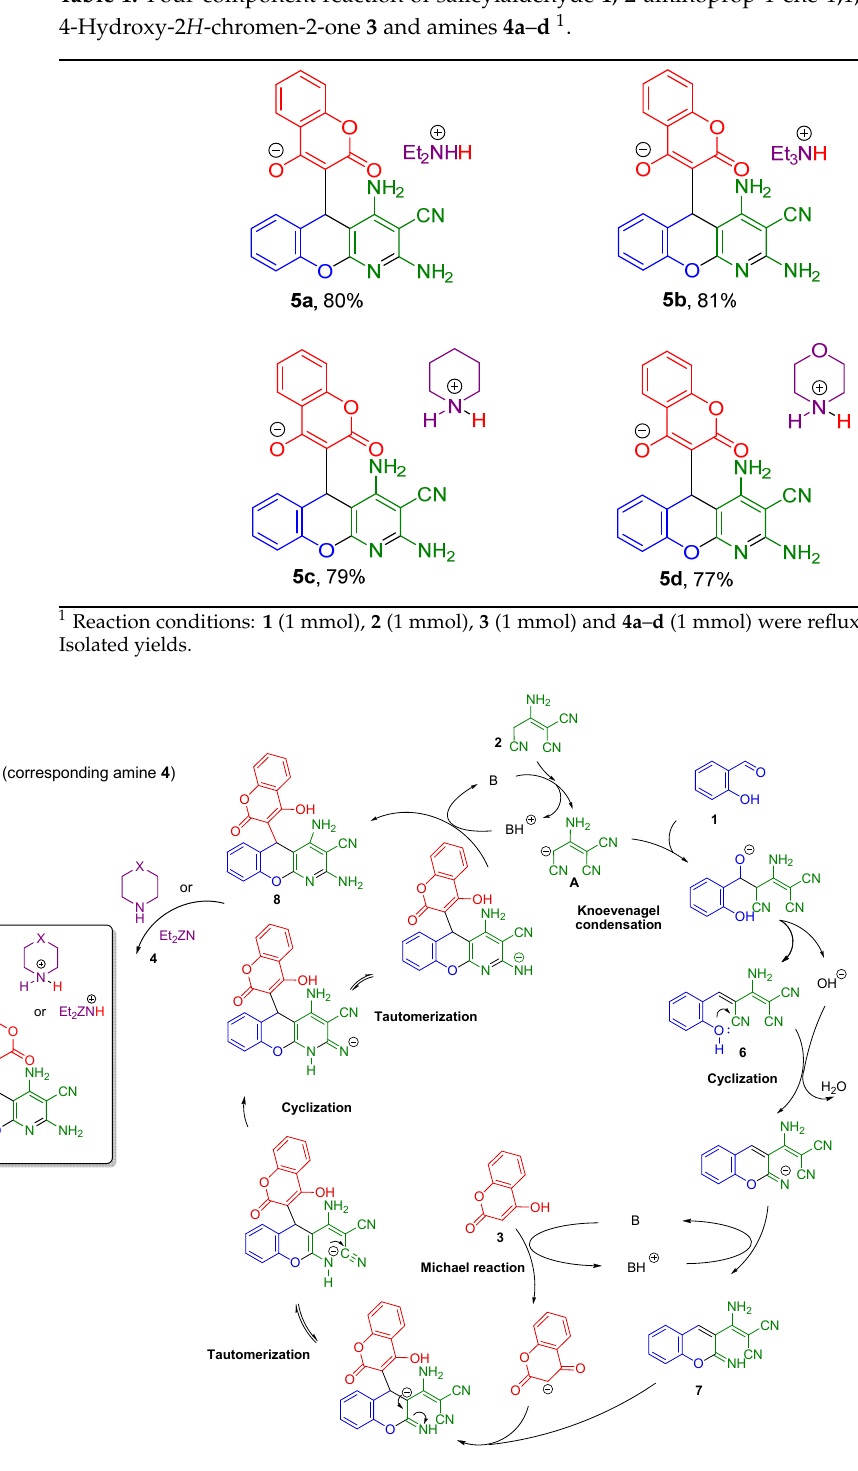
Table 1. Four-component reaction of salicylaldehyde 1 , 2-aminoprop-1-ene-1,1,3-tricarbonitrile 2 ,